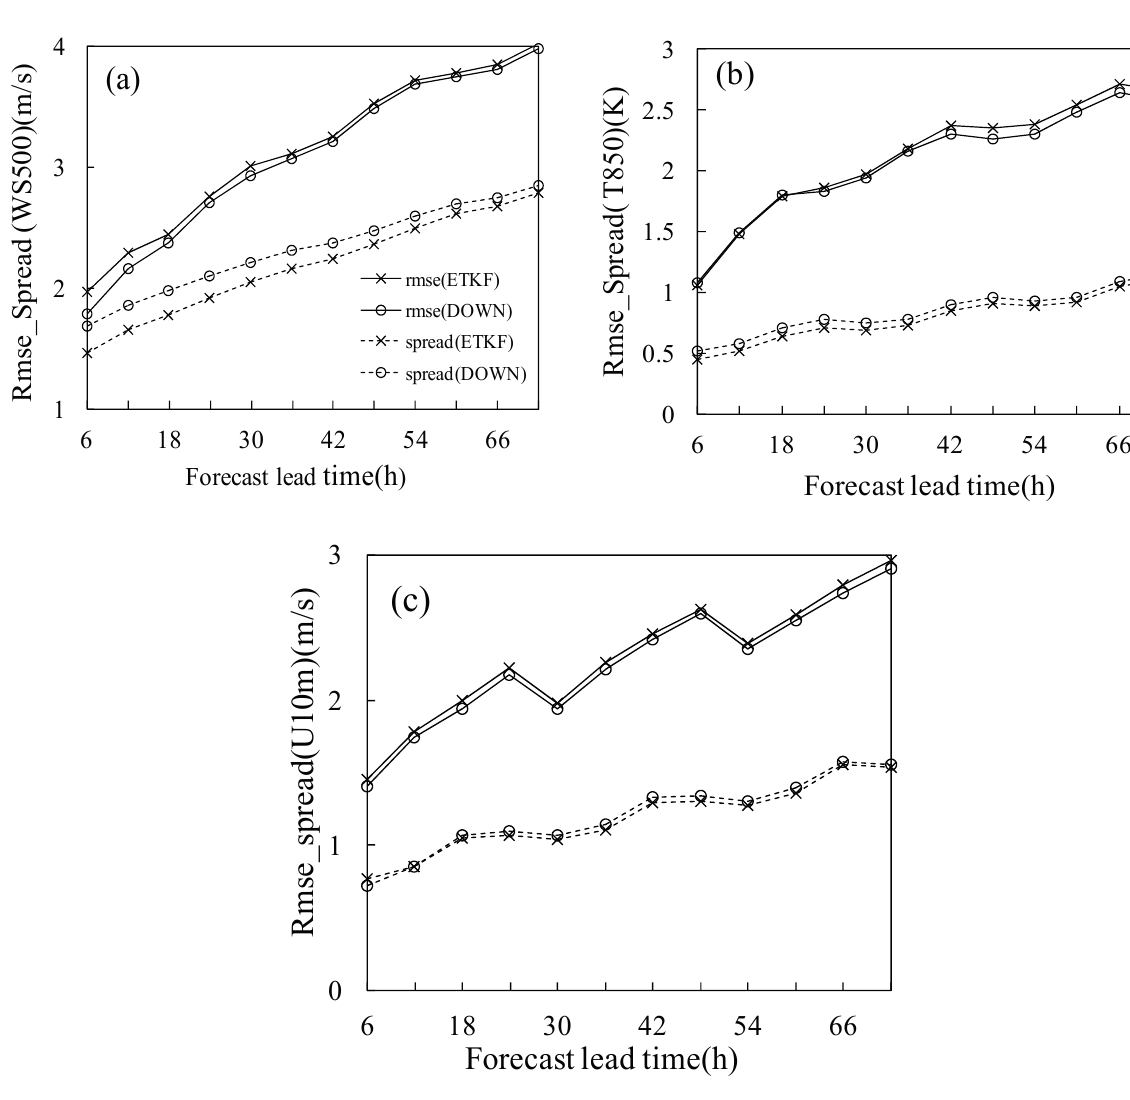
Figure 6. RMSE of ensemble mean and ensemble spread for ETKF and DOWN, respectively. ( a ) 500 hPa wind speed; ( b ) 850 hPa temperature; ( c ) 10 m U